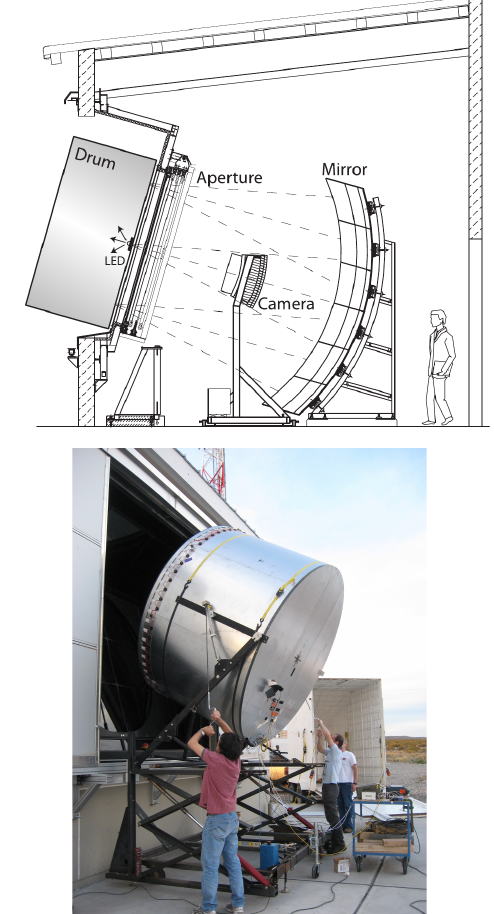
Figure 1. Scheme of the drum calibration inside the FD aperture (upper image); the drum is lifted into the aperture and several people are required for this action (lower